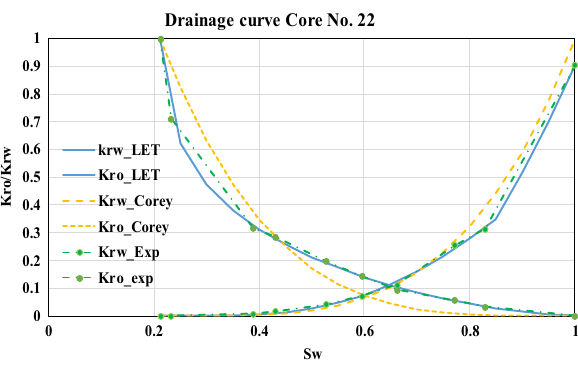
S or ), Fig. 11 Drainage K r curve matching using Corey and LET method, the LET method matches with experiment data much better than Corey method